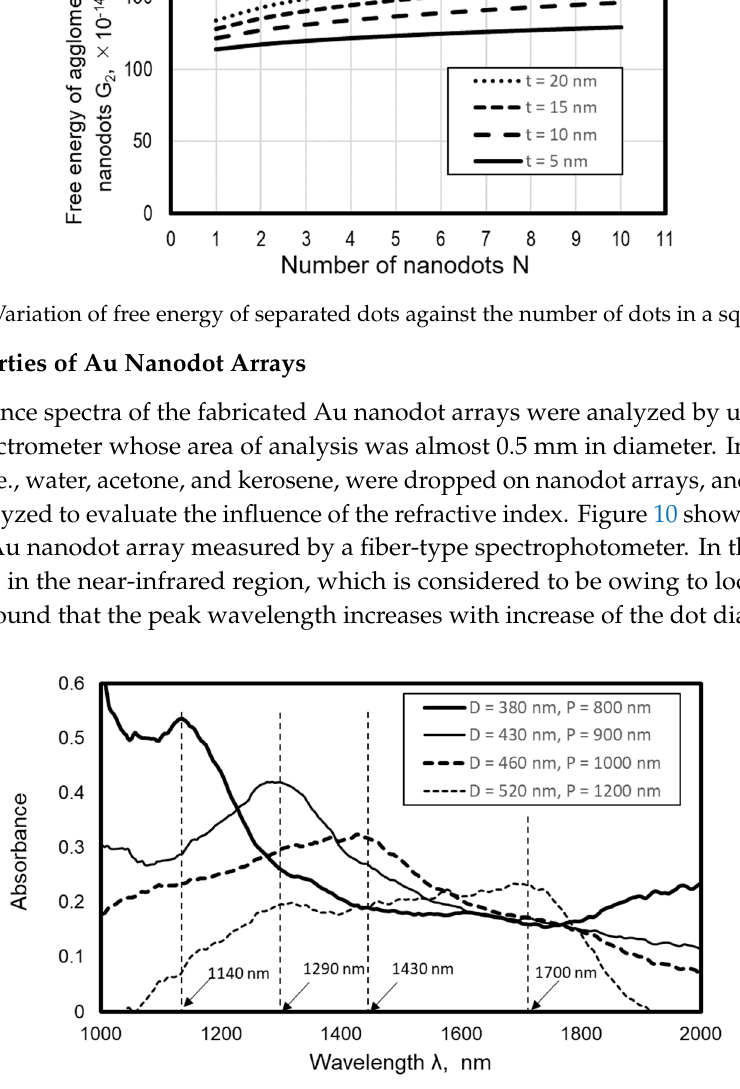
Figure 10. Influence of average dot diameter on absorbance spectrum of nanodot arrays.